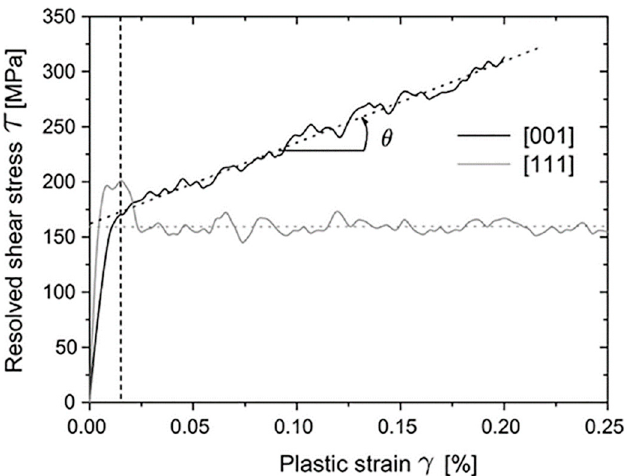
Figure 1. The stress–strain curves of single crystal nickel with an initial orientation of [001] (black line) and [111] (gray line), as obtained by the MD simulations [37].